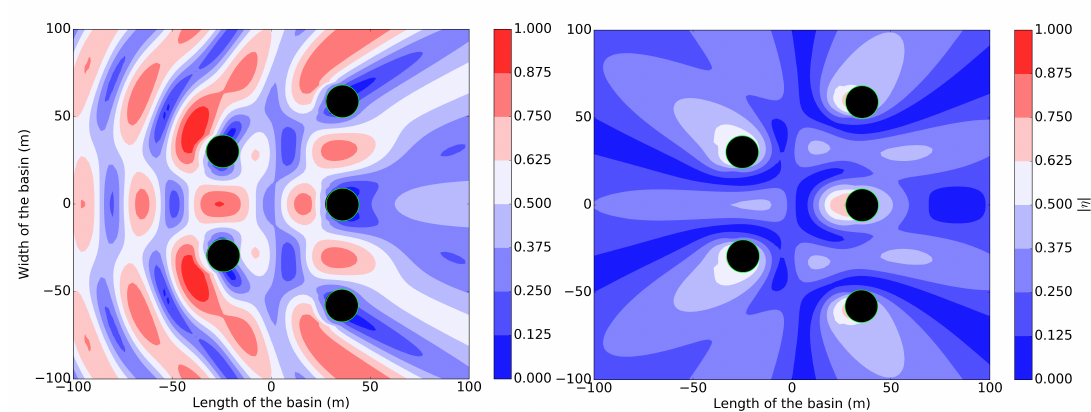
Figure 14. The total ( left ) and perturbed ( right ) | η | for a heaving cylindrical WEC for a wave of H = 1.0 m, T = 6.0 s for a linear PTO system. Incident wave propagating from the left.